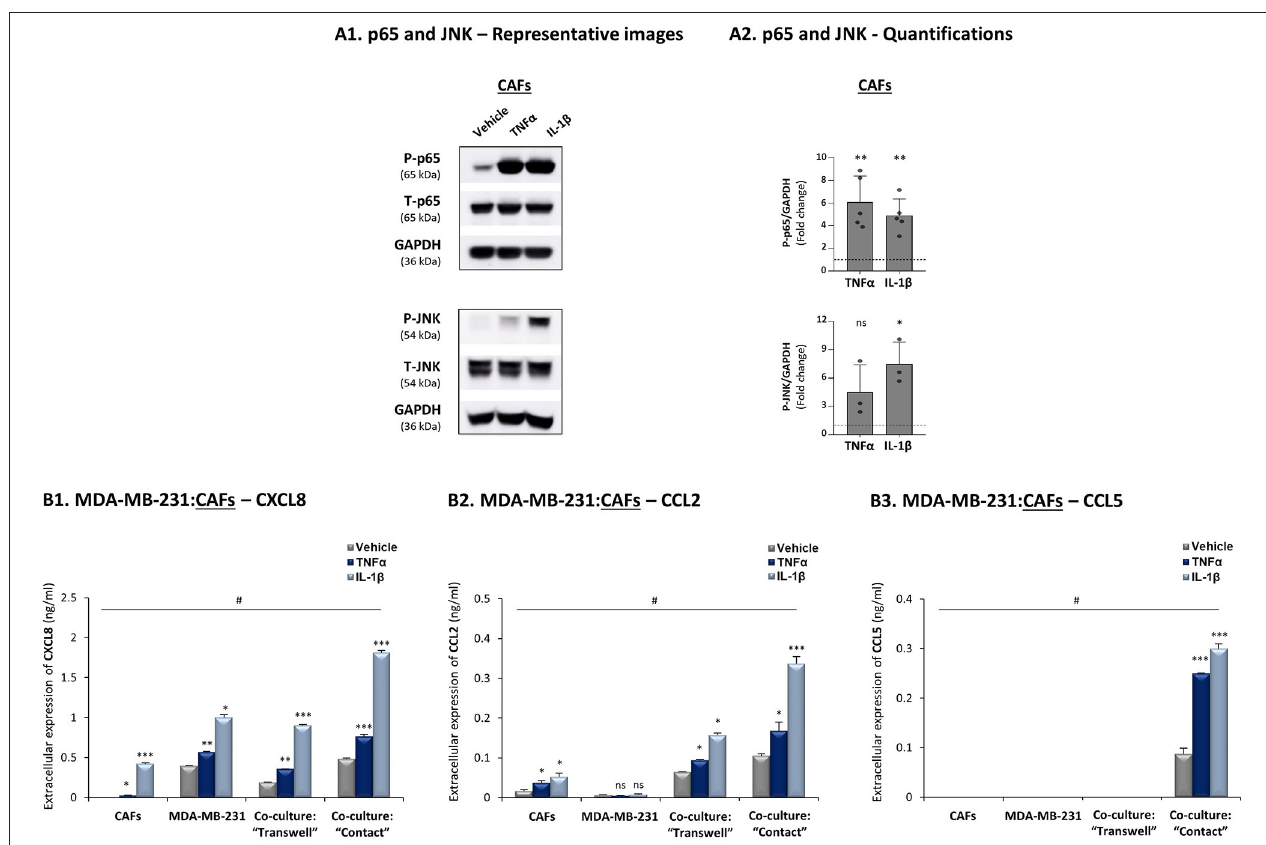
FIGURE 4 | CXCL8, CCL2 and CCL5 reach their highest expression levels when TNBC:CAF “Contact” co-cultures are stimulated by TNF α and IL-1 β . The Figure demonstrates similar experiments and statistical analyses as those of Figure 3 , performed herein with MDA-MB-231 cells and CAFs, using similar cytokine concentrations. (A) Activation of p65 and JNK. (B) CXCL8 (B1) , CCL2 (B2) and CCL5 (B3) expression levels. In all parts of the Figure, the results are of a representative experiment of n ≥ 3 independent experiments. *,**,***, # - As described in Figure 3 . ns=non-significant. ( Figure 9B1 ) toward a metastasis-relevant phenotype [in line with our findings in (83–85)]. MCF-7 cells that grew in contact with MSCs also demonstrated modifications in their morphology, different than those induced by TNF α stimulation. ( Figure 9A1 ), when TNF α was added to MCF-7:MSC “Contact” MSCs in inducing more robust morphological changes in the tumor cells ( Figure 9B1 ). Of note, the TNF α -stimulated